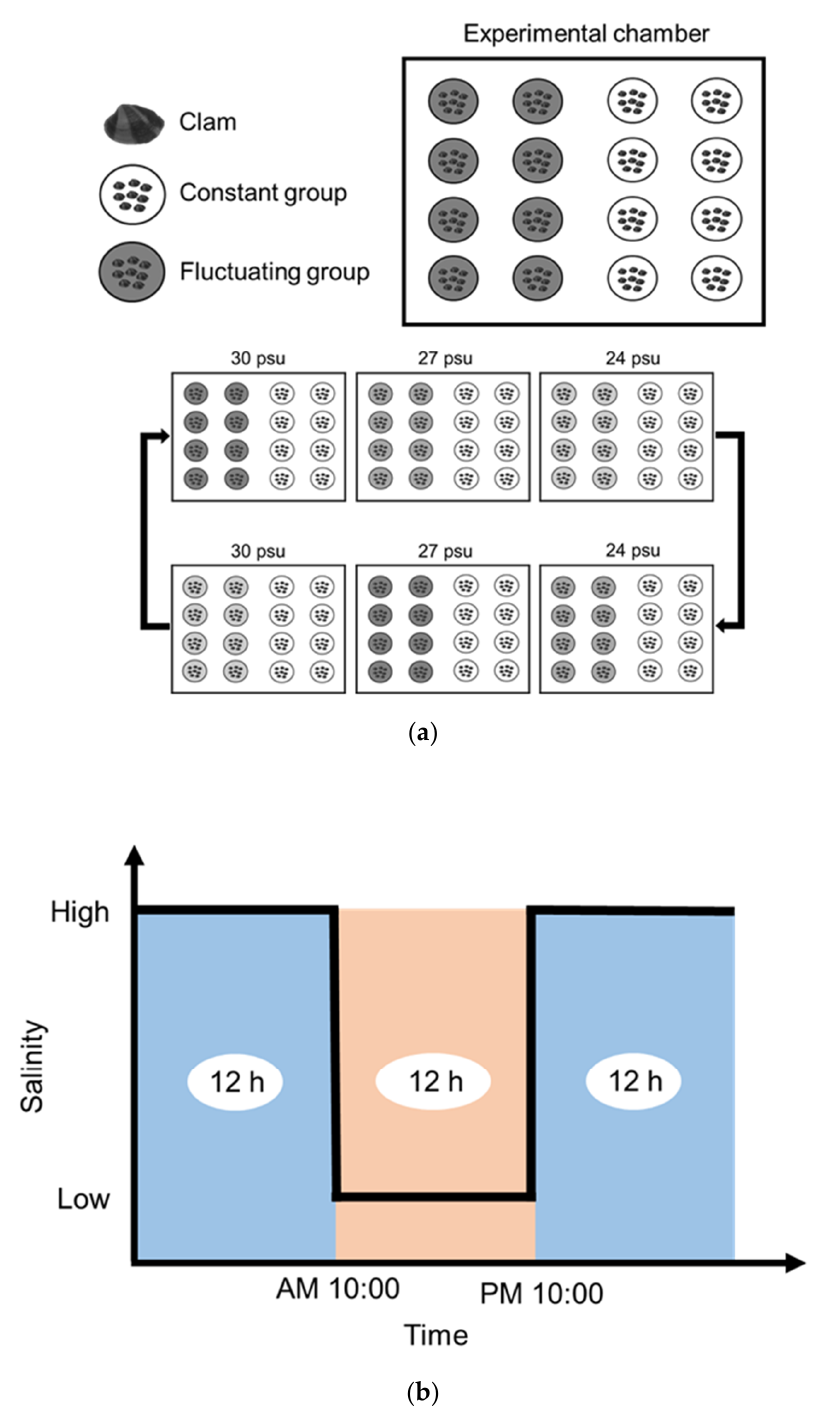
Figure 2. ( a ) Schematic diagram of Experiment 2 setup and ( b ) an example of the salinity fluctuation procedure of Experiment